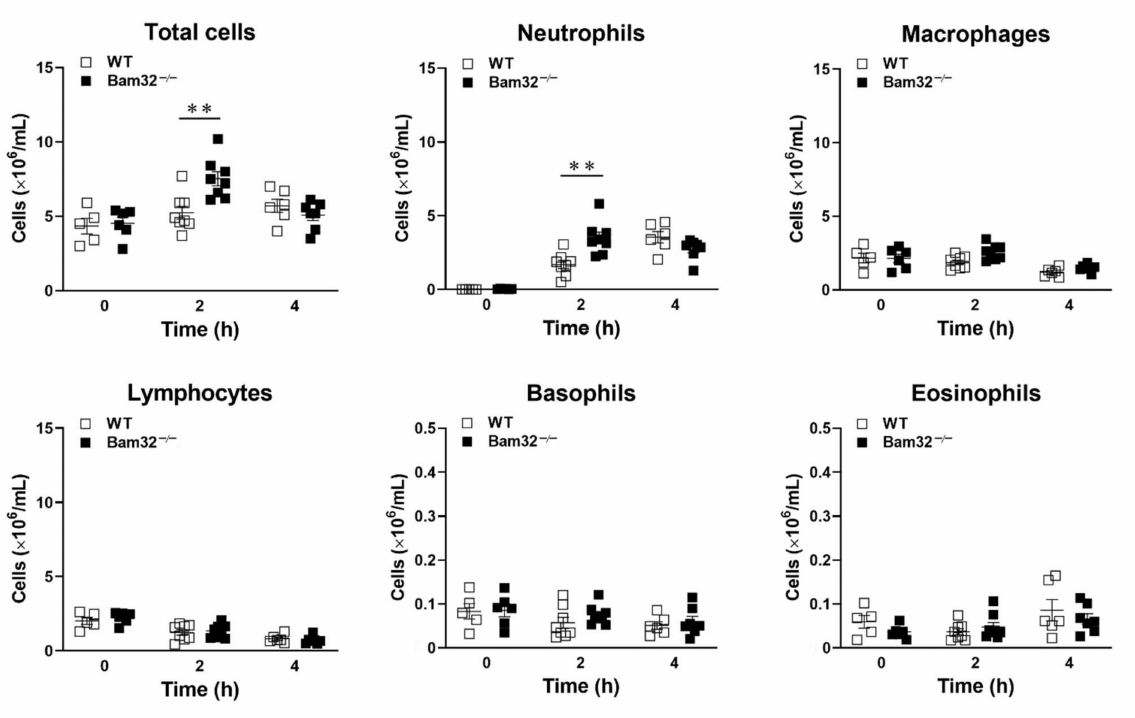
Figure 2. Effect of Bam32 deficiency on CXCL2-induced neutrophil emigration in the mouse peritoneum. The numbers of total emigrated leukocytes, neutrophils, macrophages, lymphocytes, basophils, and eosinophils were counted in peritoneal lavage fluid before (0 h) and 2 or 4 h after the intraperitoneal injection of CXCL2 (0.5 µ g/25 g body weight). Mean ± SEM of 5 − 8 mice per group. ** indicates significant differences ( p < 0.01) between WT and Bam32 − / − mouse